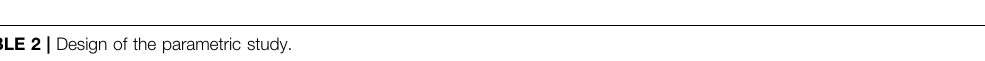
TABLE 2 | Design of the parametric